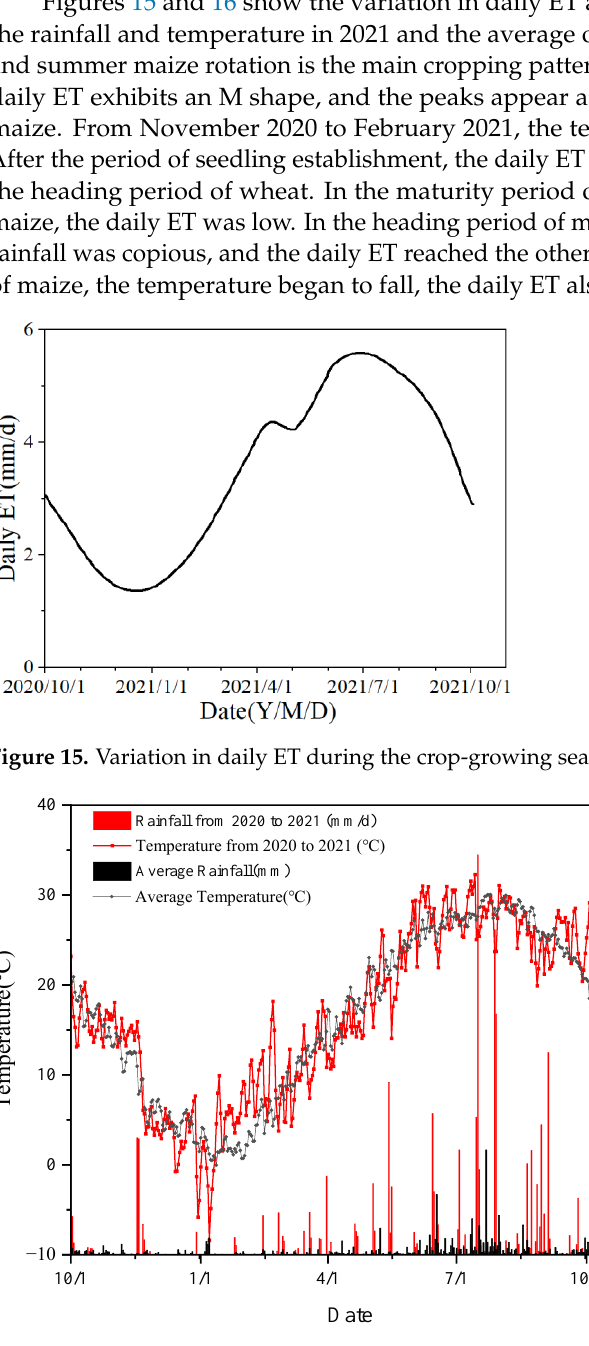
Figure 17. Variation in the ratio of actual to potential ET for different phenological periods.